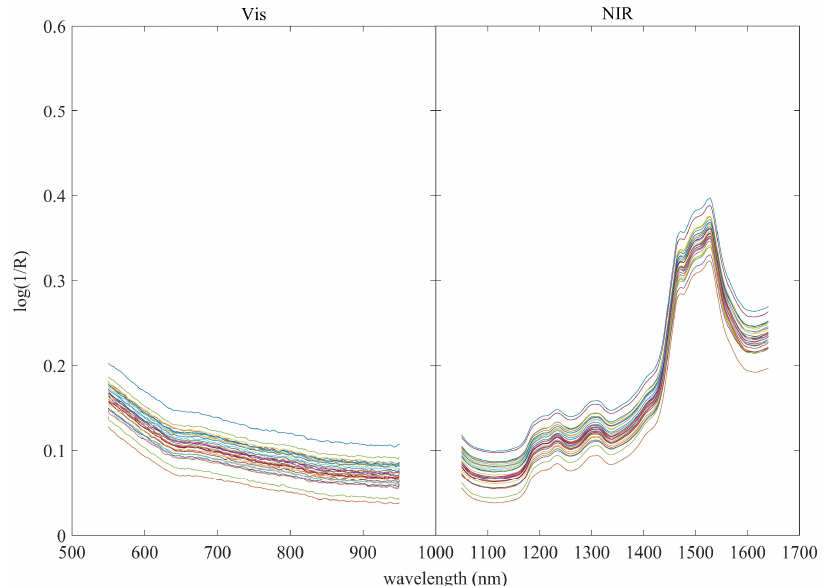
Figure 3. Original spectral curves of fertilizers (each color of the curve in the figure represents a sample).